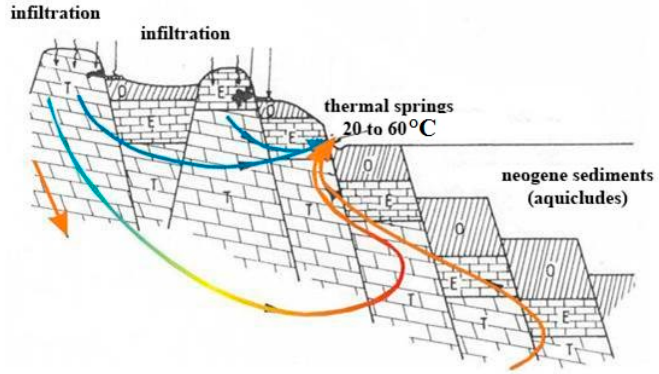
Figure 2. Conceptual flow model of the Buda Thermal Karst system from Vendel–Kisházi (1964) [9]. Abbreviations: T—Triassic dolomite; E—Eocene limestone and Eocene–Oligocene marl; O—Oligocene clay.